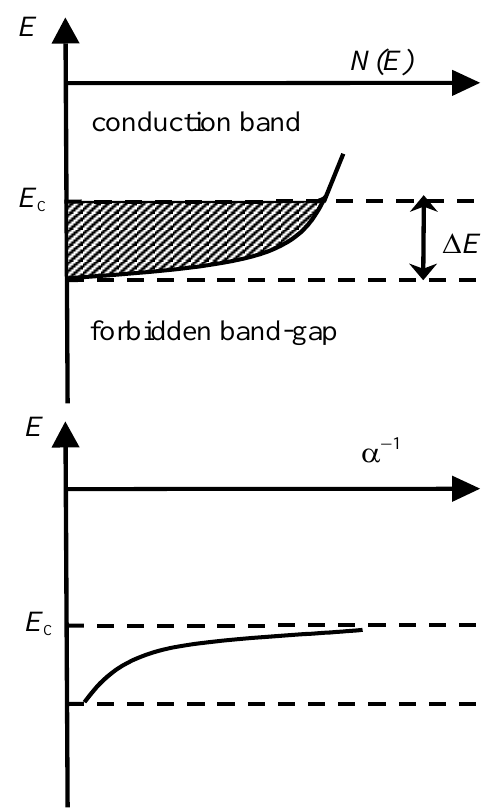
Fig. 2 . The allowed one-electron quantum states in a disordered solid. Besides the extended states of the conduction band lying above the mobility edge E , there exists a tail of c localized states (hatched area) over a range  E . The conduction band is virtually empty if the solid is semiconducting. Top: density of allowed states N ( E ). Bottom: decay length  − 1 of the localized states; at the mobility edge,  − 1 is becoming infinite which corresponds to an extended (Bloch) state. After figure 6.8 of